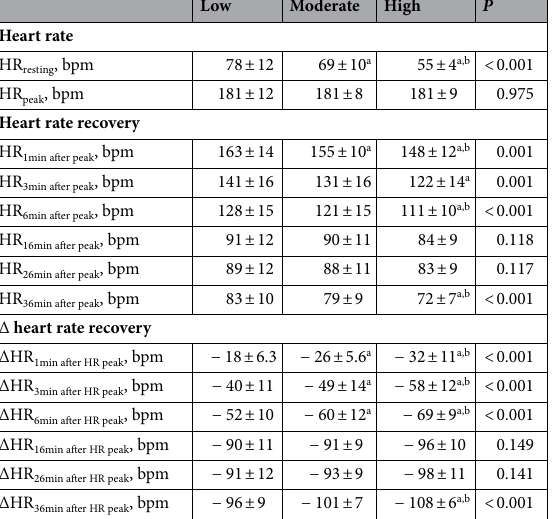
Table 2. Values of heart rate and heart rate variation delta (∆) obtained in all groups at rest, at peak of cardiopulmonary test and during recovery. Values are presented as mean ± SD. HR heart rate; bpm, beats per minute. a P < 0.05 vs. low cardiorespiratory fitness group. b P < 0.05 vs. moderate cardiorespiratory fitness